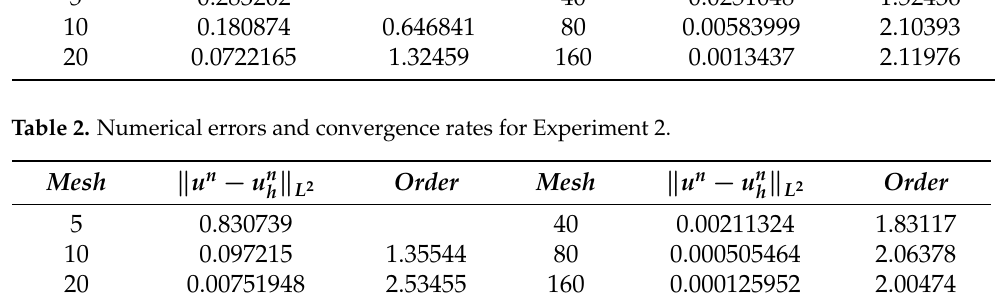
Table 3. Numerical errors and convergence rates for Experiment 3.